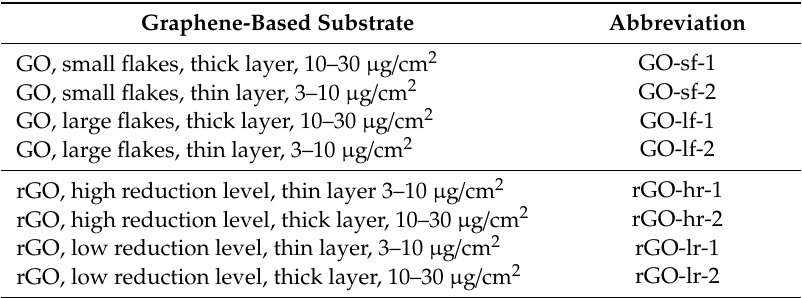
Table 2. Types of graphene-based materials that were used as substrates for hUC-MSCs growth. Graphene-Based